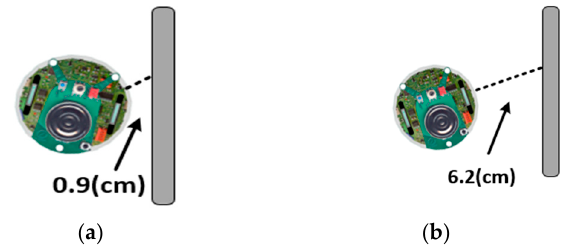
Figure 12. Mobile robot ( a ) collides with the wall ( b ) deviates from the wall.